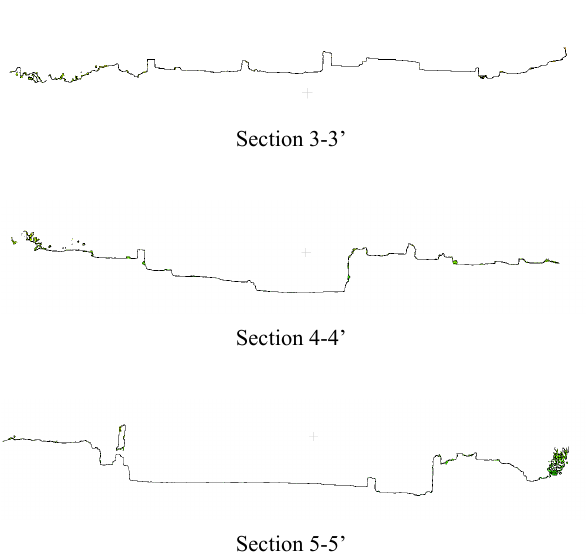
Figure 16. Cross sections extracted from the 3D model (rough direction: north-west /